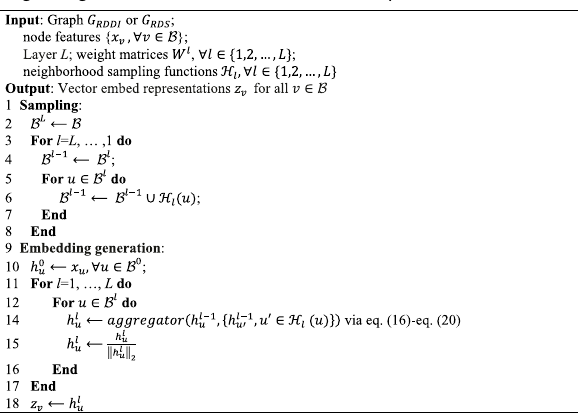
Algorithm 1. GraphSAGE minibatch forward propagation